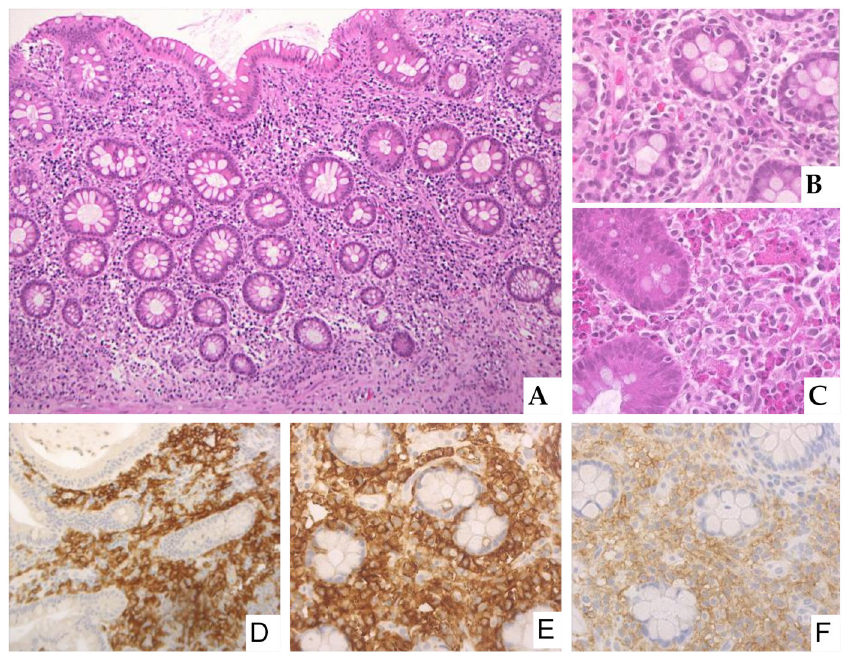
Figure 1. Low power view of large bowel lamina propria expanded by a polymorphous infiltrate of oval to spindle-shaped mast cells with admixed granulocytes, small lymphocytes, and plasma cells (panel ( A ), Hematoxilin and eosin, magnification 100 × ). High power view of the infiltrate in the lamina propria (panel ( B ), Hematoxylin and eosin, magnification 400 × ). High power view of the infiltrate rich in eosinophilic granulocytes (panel ( C ), Hematoxylin and eosin, magnification 400 × ). Tryptase positivity highlighting mast cell infiltrate (panel ( D ), immunostain, magnification 400 × ); CD117 positivity (panel ( E ), immunostain, magnification 400 × ); CD25 expression indicative of clonal mast cells (panel ( F ), immunostain, magnification 400 ×